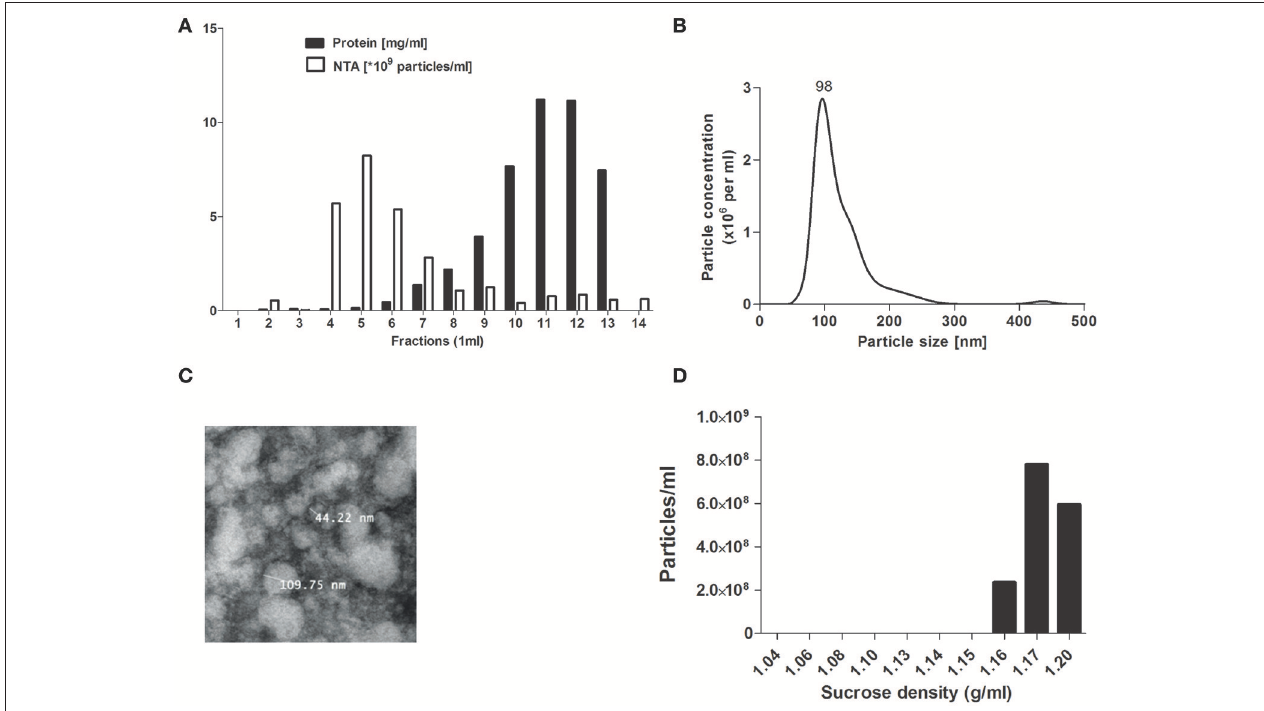
FIGURE 1 | pEV isolation by SEC. Platelet free plasma components were separated by size exclusion chromatography (SEC). For each 1ml fraction, protein and particle concentrations were measured by micro-BCA protein assay and Nanosight tracking analysis (NTA) (A) . Particle size from SEC fraction 5 was analyzed by NTA (B) and TEM (C) . Density of pEVs was determined by use of a sucrose gradient and particles of each density fraction were measured by NTA (D) .